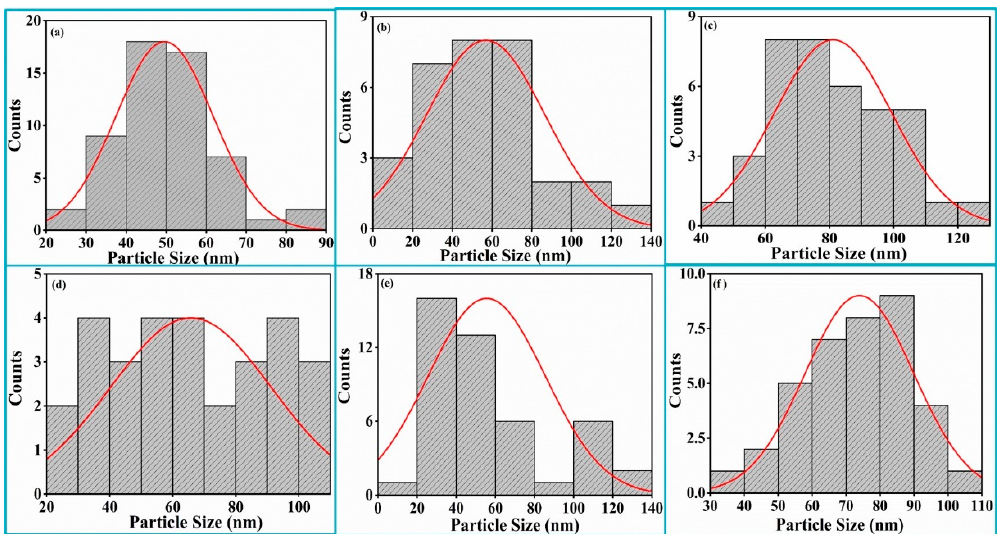
Figure 6. Histograms for particle size distribution and Gaussian fitting curves of the Bi 2 O 3 :Ho 3+ thin films deposited at different substrate temperatures: ( a ) RT, ( b ) 200 °C, ( c ) 300 °C ( d ) 400 °C, ( e ) 500 °C and ( f ) 600 °C.